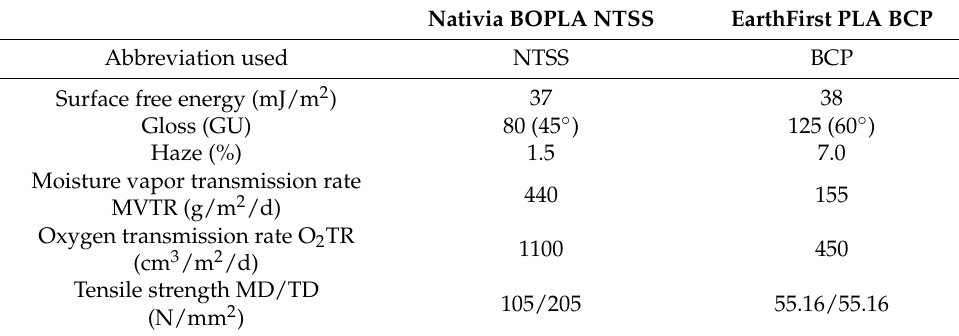
Table 1. The characteristics of the films used in the study.